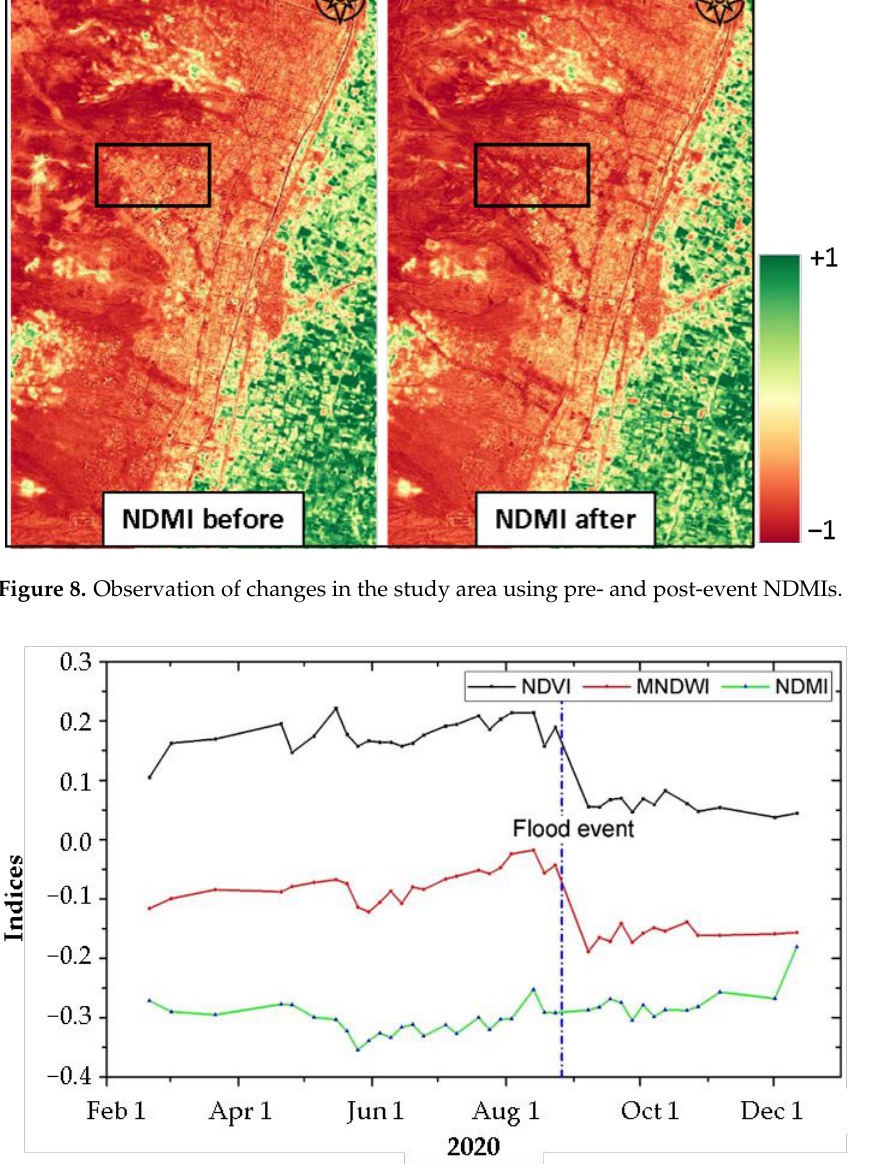
Figure 9. Time series of the NDVI, MNDWI, and NDMI over the course of one year in affected area. The blue dotted line indicates the date of the flash flood in Charikar.